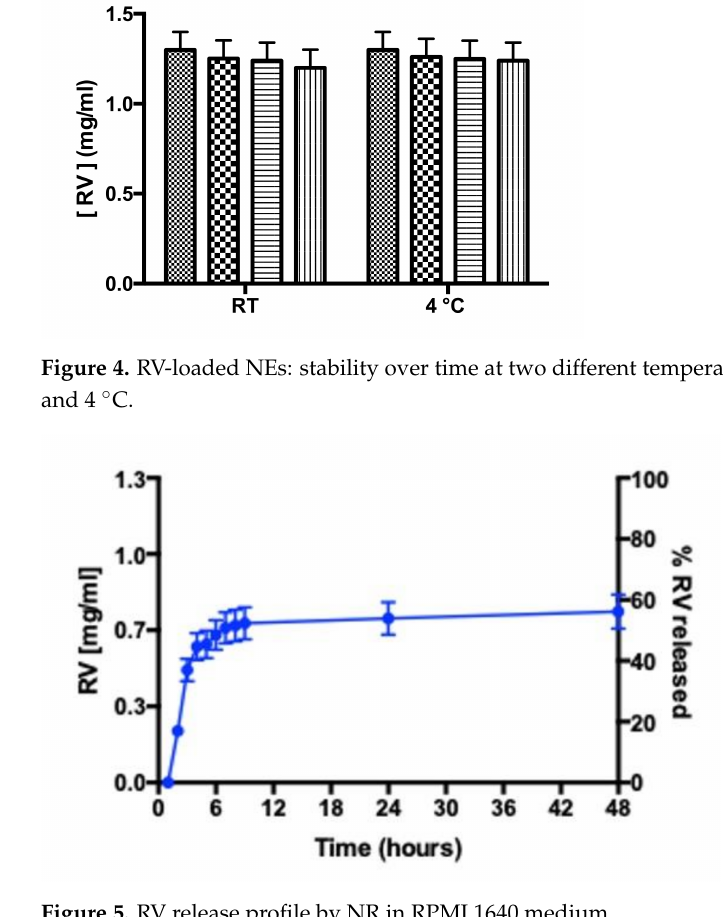
Figure 5. RV release profile by NR in RPMI 1640 medium.